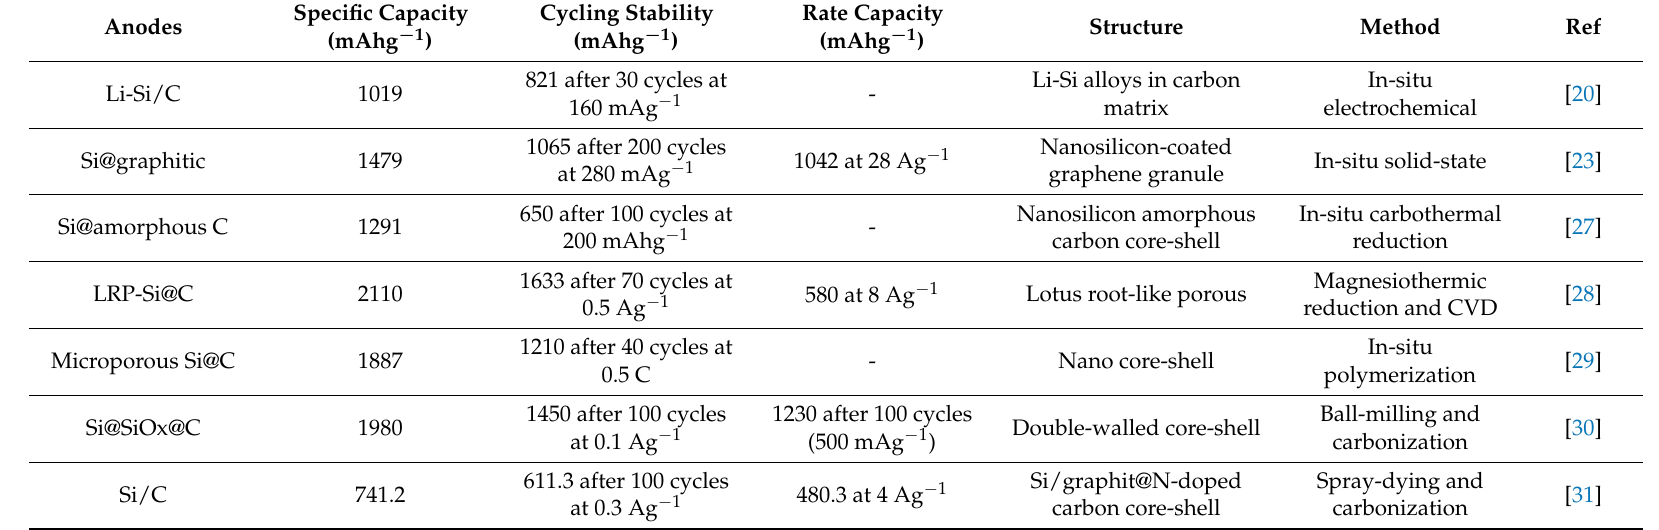
Table 2. Synthesis method and electrochemical performance comparison of Si@C-based anode materials in the lithium ion battery.